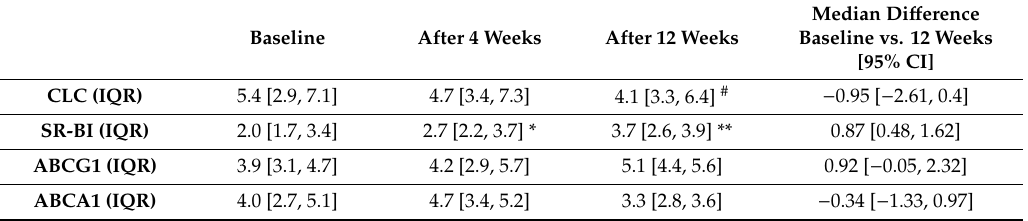
Table 1. Serum cholesterol loading capacity (CLC) and cholesterol e ffl ux capacity (CEC) measured by three di ff erent pathways at baseline and after 4 and 12 weeks of treatment with tocilizumab. Baseline After 4 Weeks After 12 Weeks